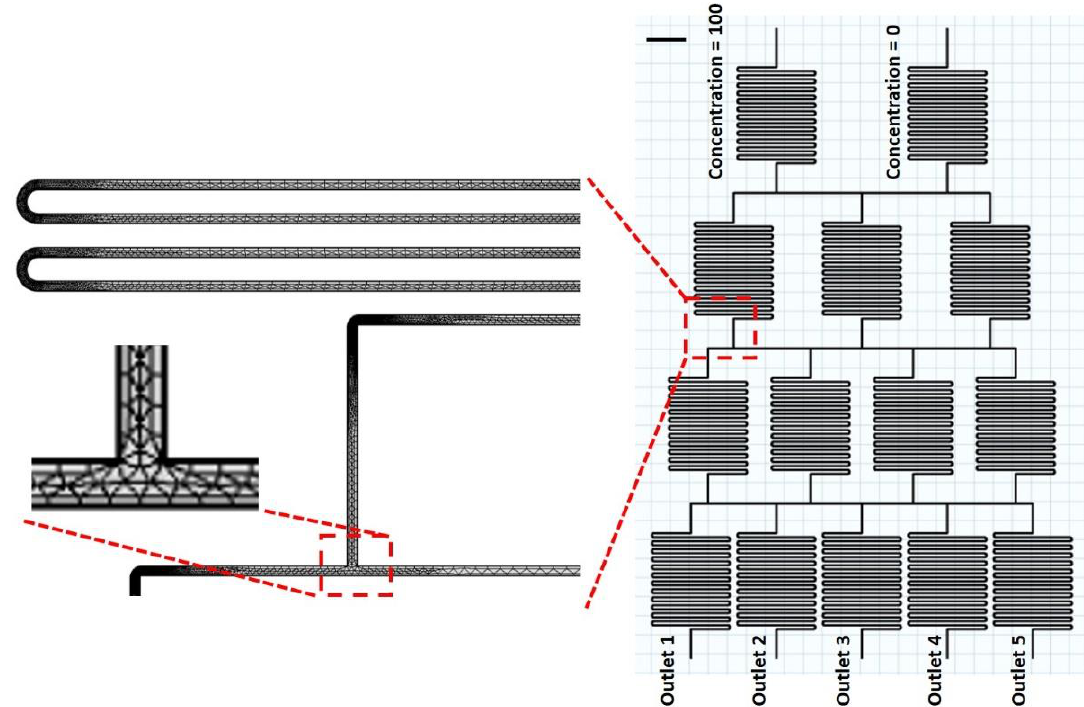
Figure 2. Modified, five-outlet design with a part of the mesh in COMSOL simulation. The extremely fine mesh was applied. Scale bar = 2 mm.